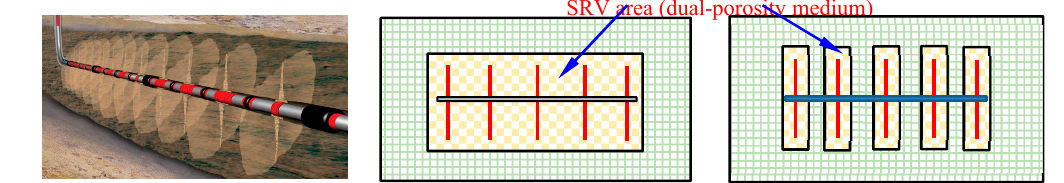
Figure 9. DFN model mesh of a fracture network system in shale.